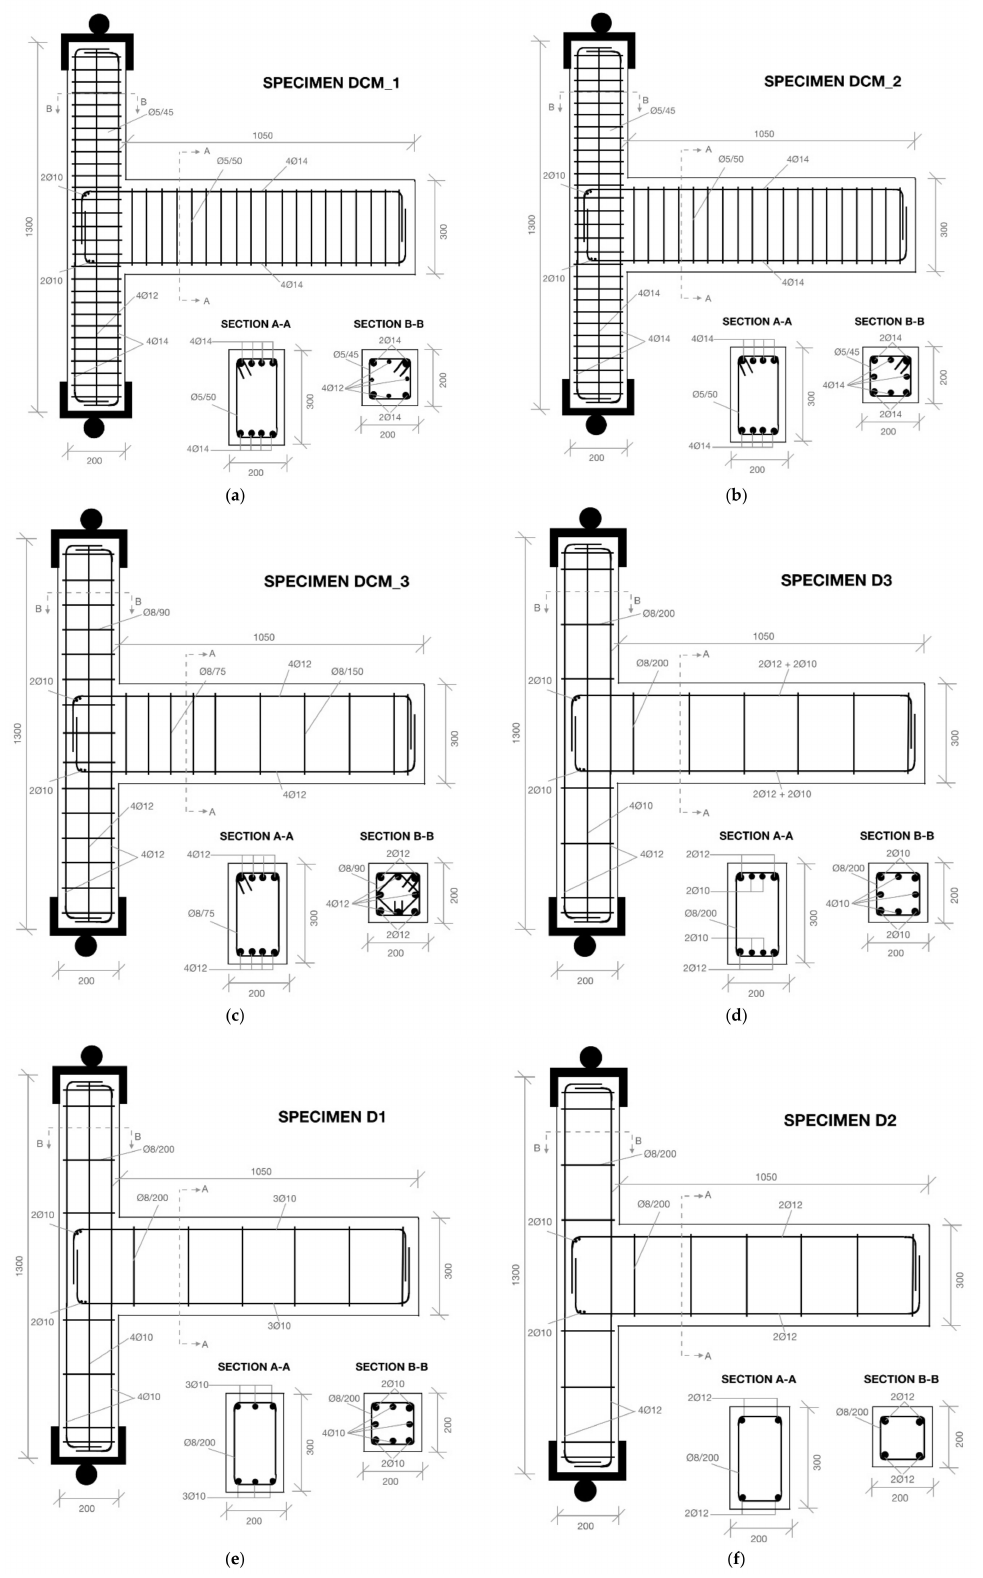
Figure 1. Dimensions, reinforcement, and cross-section details of subassemblages ( a )